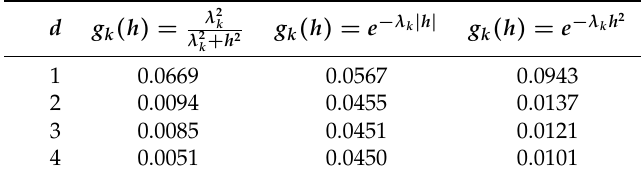
Table 1. Square root errors: Brent vs. WTI oil. Number of lags: 150 days.